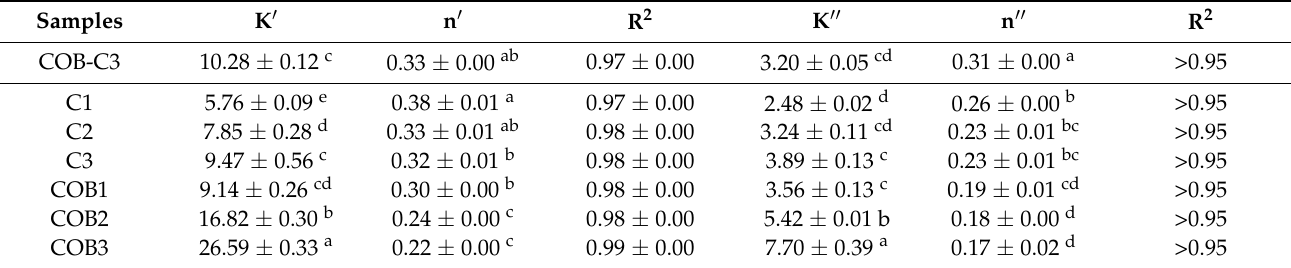
Table 3. Dynamical rheological properties of plant-based ice cream mixes.